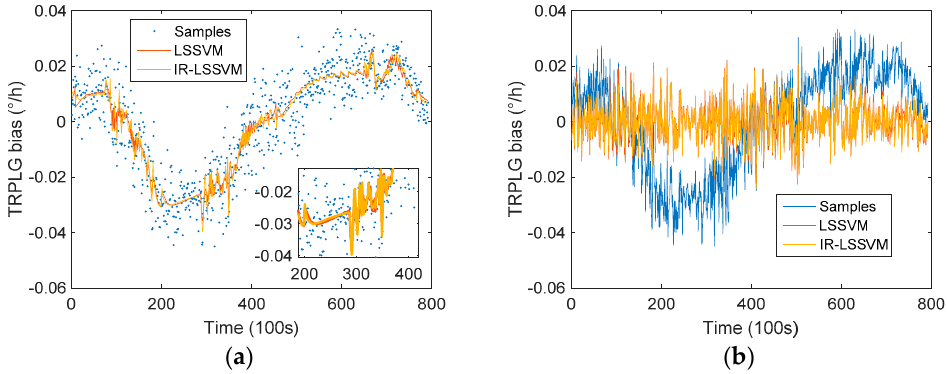
Figure 11. TRPLG bias compensation based on LSSVM model and IR-LSSVM model: ( a ) Regression based on all parameters; ( b ) Compensation based on all parameters.